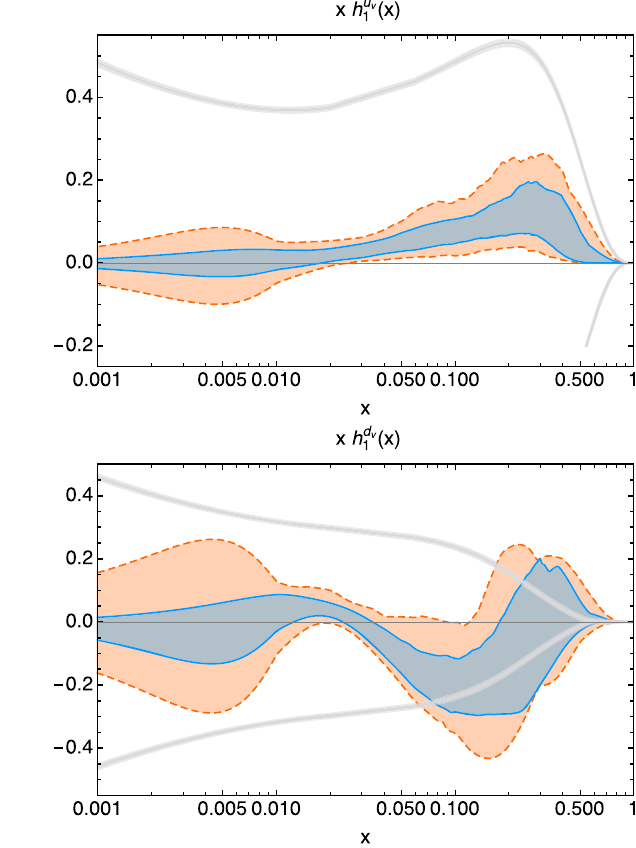
Fig. 4 Valence transversities: 68% envelope for the present fit for the four different degrees of the Bernstein polynomial of the functional form, respectively, n = 10 , 20 , 30 , 40 in red with dot-dashed contours, purple/dashed, yellow/full and green/dotted, for the up (upper) and the down (lower)